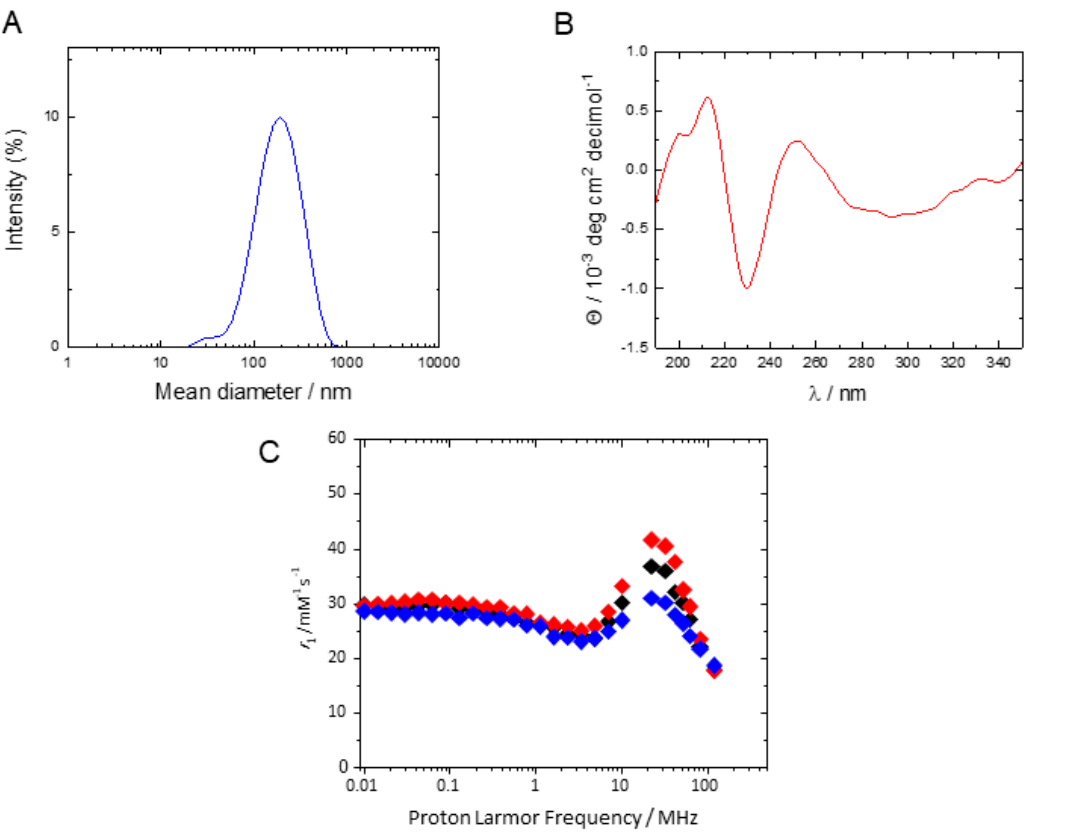
Figure 6. Structural and relaxometric characterization of Fmoc-K2 NG loaded with [Gd(BOPTA)] 2 − . ( A ) CD profile of the NG solution recorded in the range between 350 and 190 nm; ( B ) Dynamic light scattering profile and the paramagnetic NG; ( C ) 1 H NMRD profile of the nanogel at 283 (blue), 298 (black) and 310 K (red).